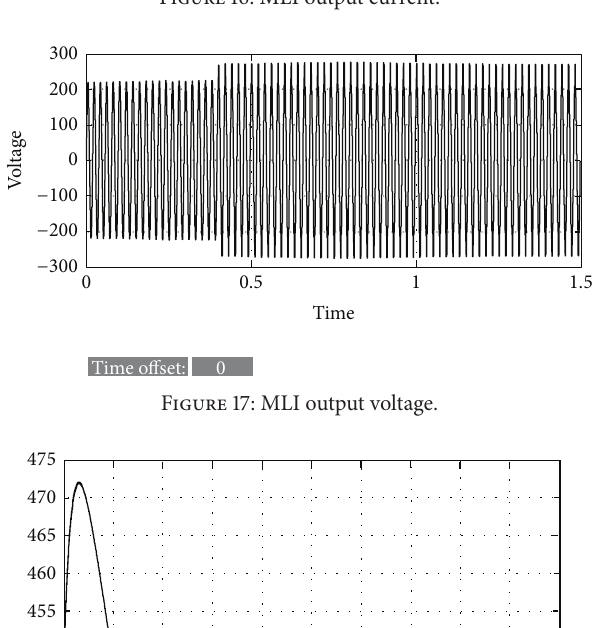
Figure 16: MLI output current.